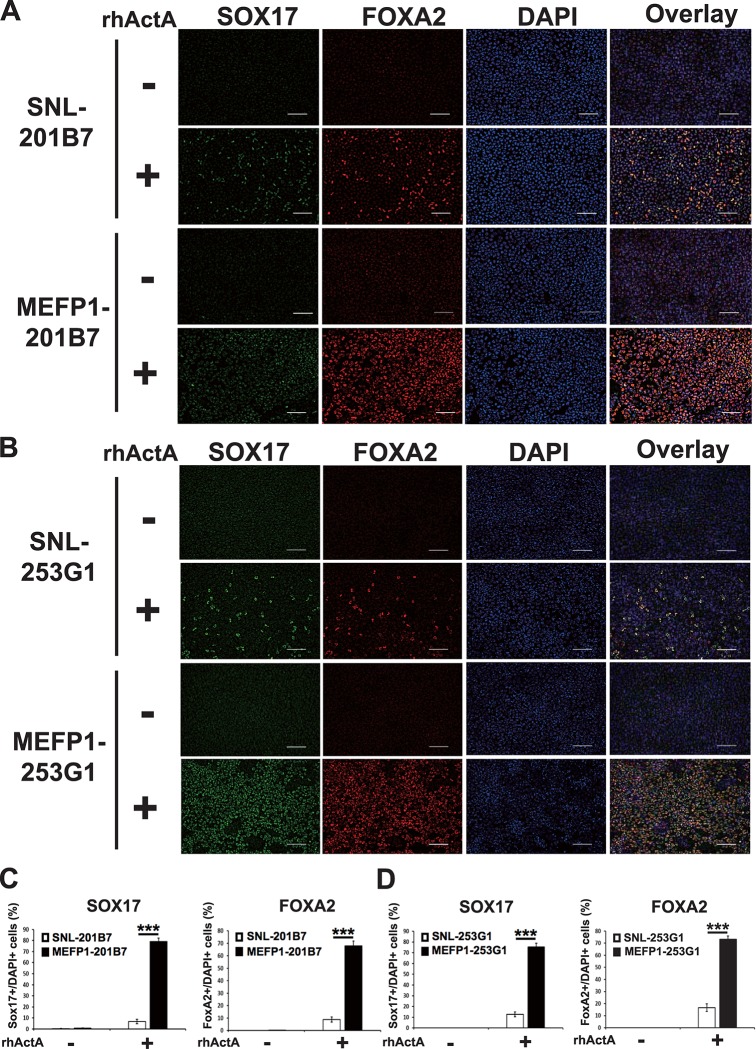
Immunofluorescent staining of SOX17 and FOXA2 proteins in DE differentiated SNL-201B7 and -253G1 or MEFP1-201B7 and -253G1 cells.The images of SOX17 (green) and FOXA2 (red), and DAPI (blue) are shown (A and B). White scale bars, 100 μm. The percentages of SOX17 (C and D, left panels) and FOXA2 (C and D, right panels)-positive cells per DAPI-positive cells (201B7, n = 10 each and 253G1, n = 8 each) were calculated based on DE marker-positive and DAPI-positive cell numbers. Data represent the mean ± SEM and are representative of three experiments. ***p < 0.001 versus SNL-201B7 and -253G1 cells.